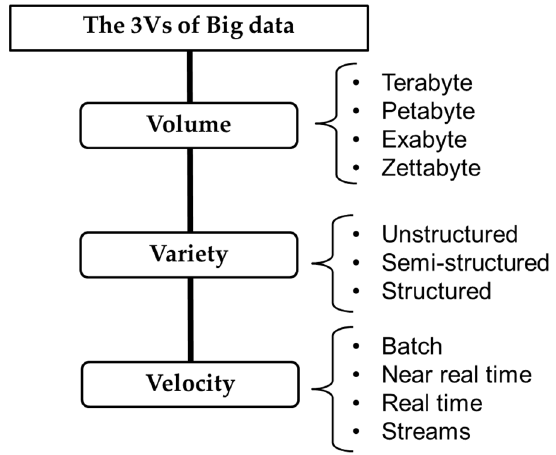
Figure 5. The three “Vs” of big data characteristics [58].